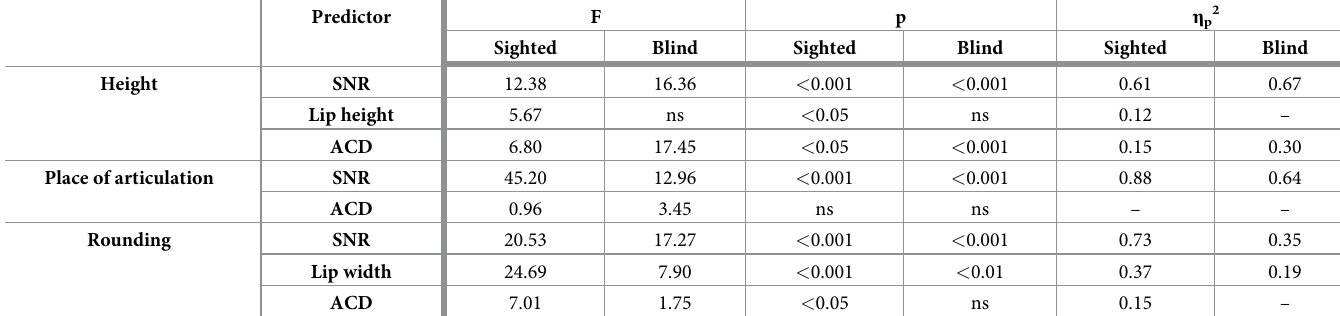
Table 5. Results of multiple regression analyses. The dependent variable is the percentage of transmitted information for each